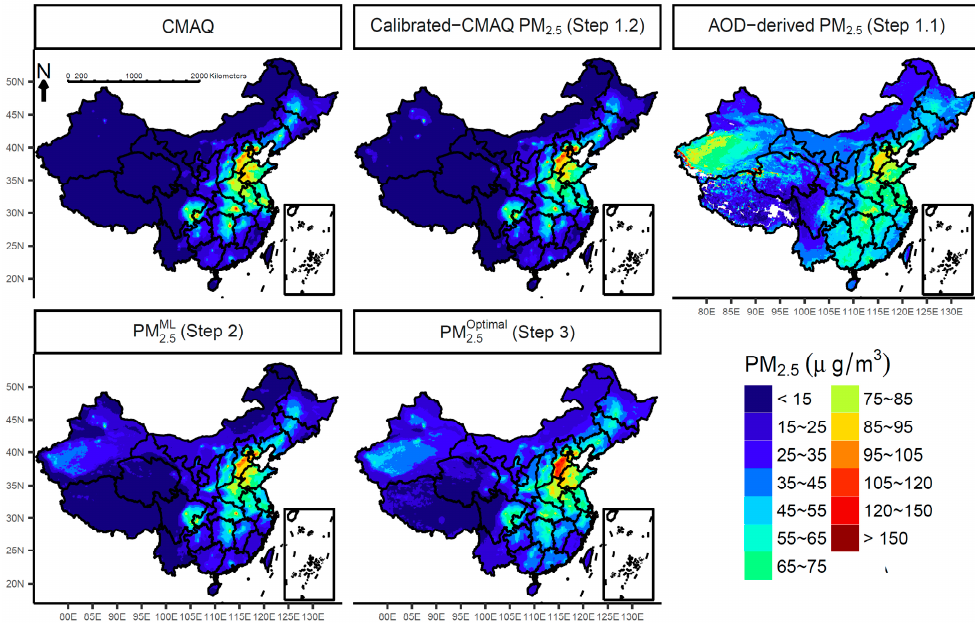
Figure 6. Annual maps (0.1° × 0.1°) of PM 2.5 during 2014 over China produced by CMAQ, intermediate and final estimators of the three-stage model.